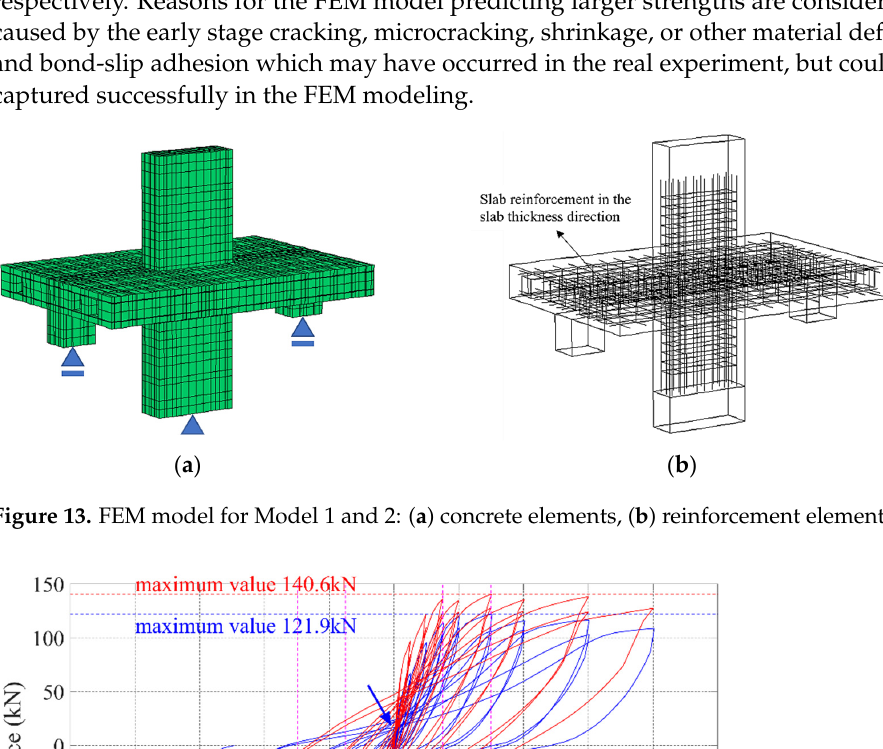
Figure 13. FEM model for Model 1 and 2: ( a ) concrete elements, ( b ) reinforcement elements.